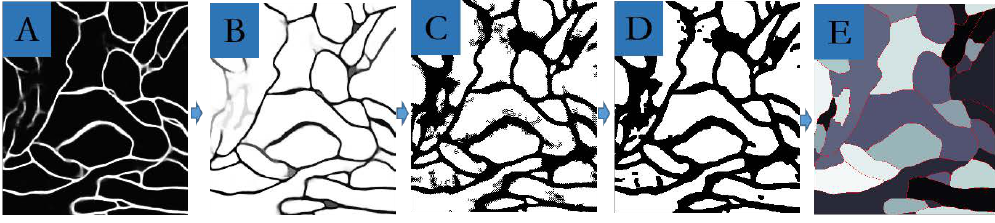
Figure 8. The workflow of segmenting neurons based on the probability map of the neuronal membrane. ( A ) Input probability map of the neuronal membrane; ( B ) the complement of the input probability map; ( C ) foreground marker; ( D ) rectified foreground marker; ( E ) neuron